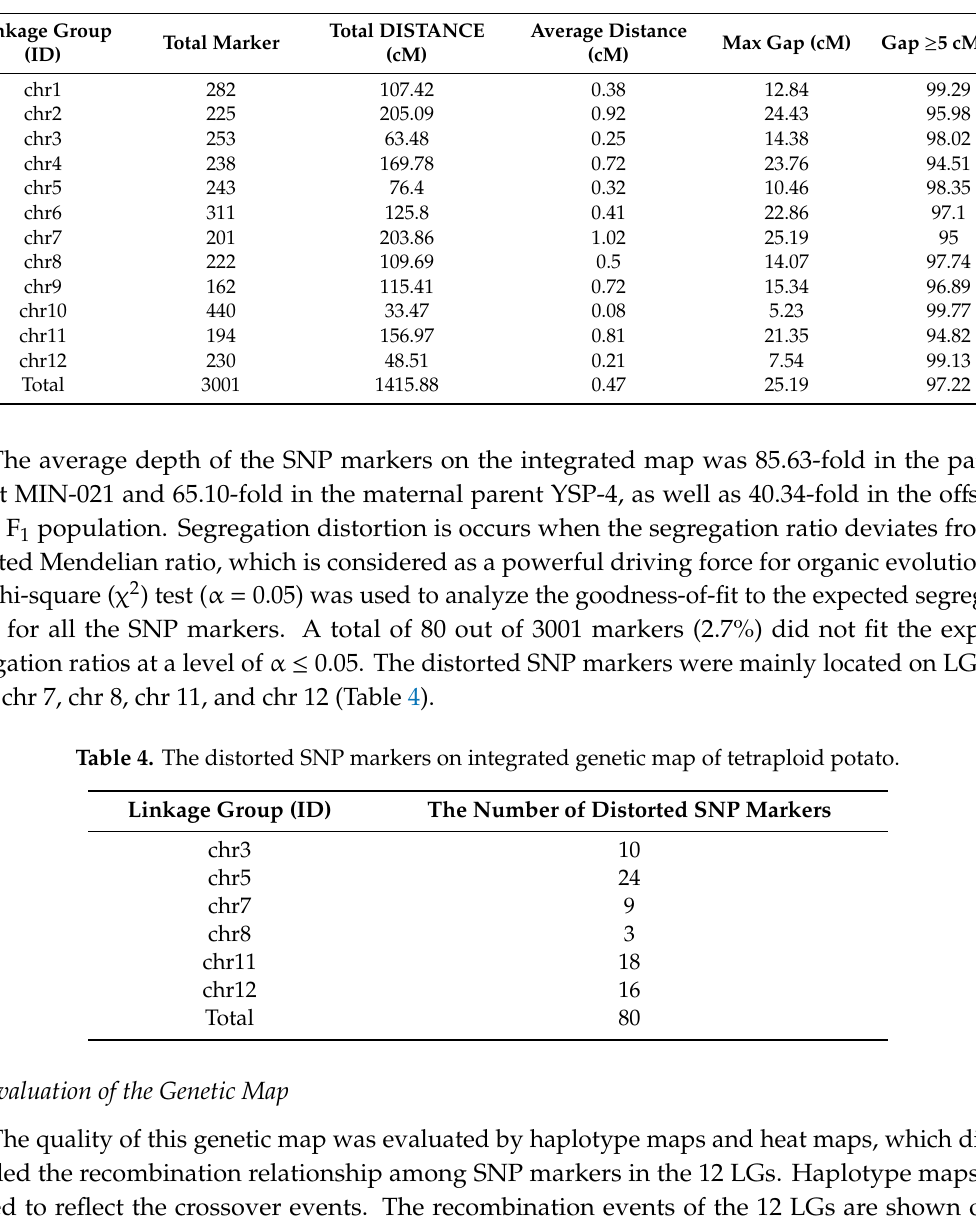
Table 3. The integrated genetic map for tetraploid potato.